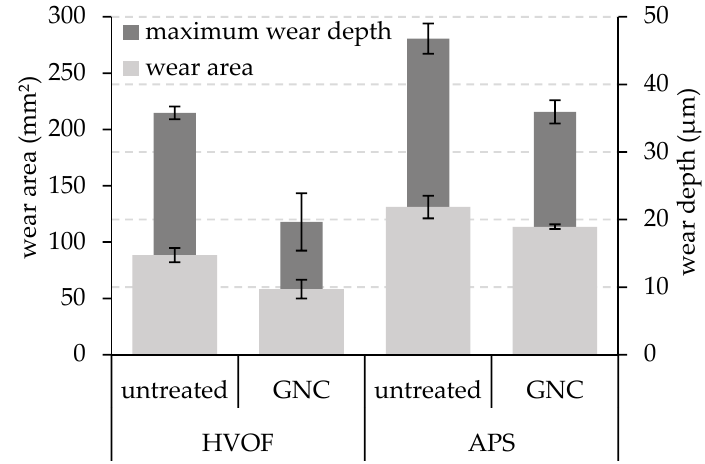
Figure 6. Comparison of the results for wear area and wear depth in scratch tests of HVOF and APS coatings, depending on the treatment state of the powder.